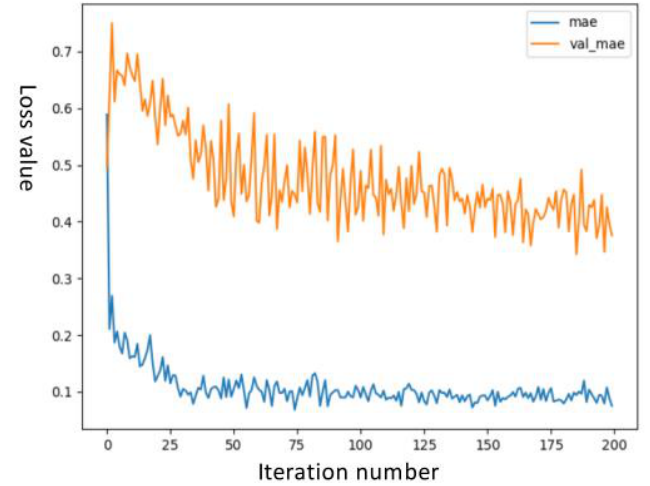
Figure 11. MAE on the training and validation sets.